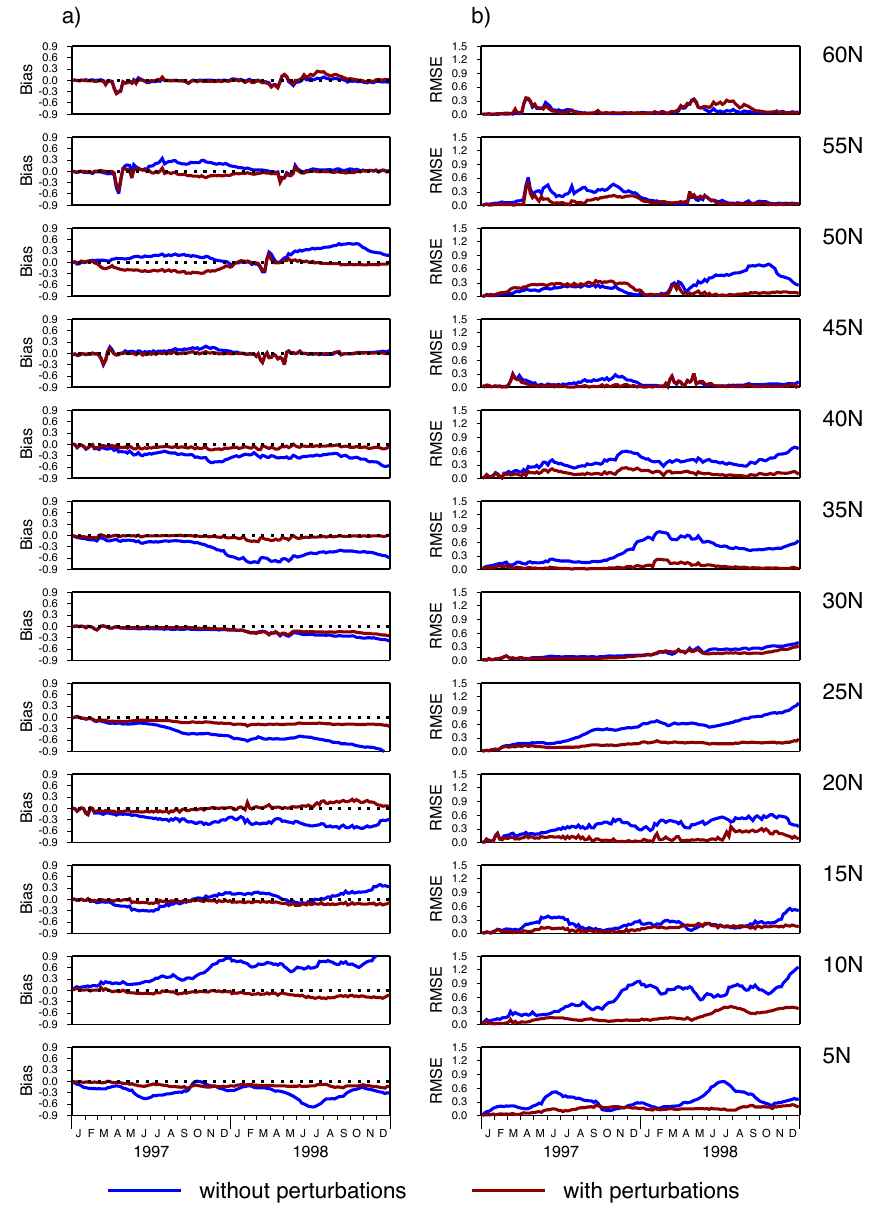
Figure 9. Informed simulator error statistics for log 10 (surface chlorophyll) (mgm − 3 ) over 10 experiments, one experiment for each of the parameter vectors in Table 2. (a) Bias and (b) rms error. The statistics are shown for informed simulators with and without lateral flux